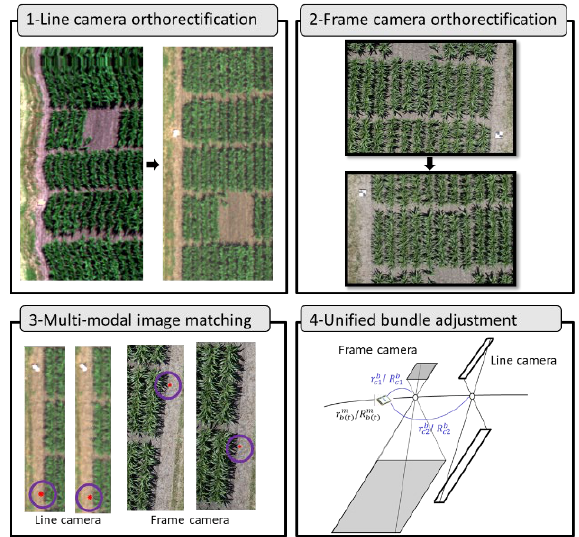
Figure 4. Schematic diagram of the involved steps in the proposed multi-modal triangulation